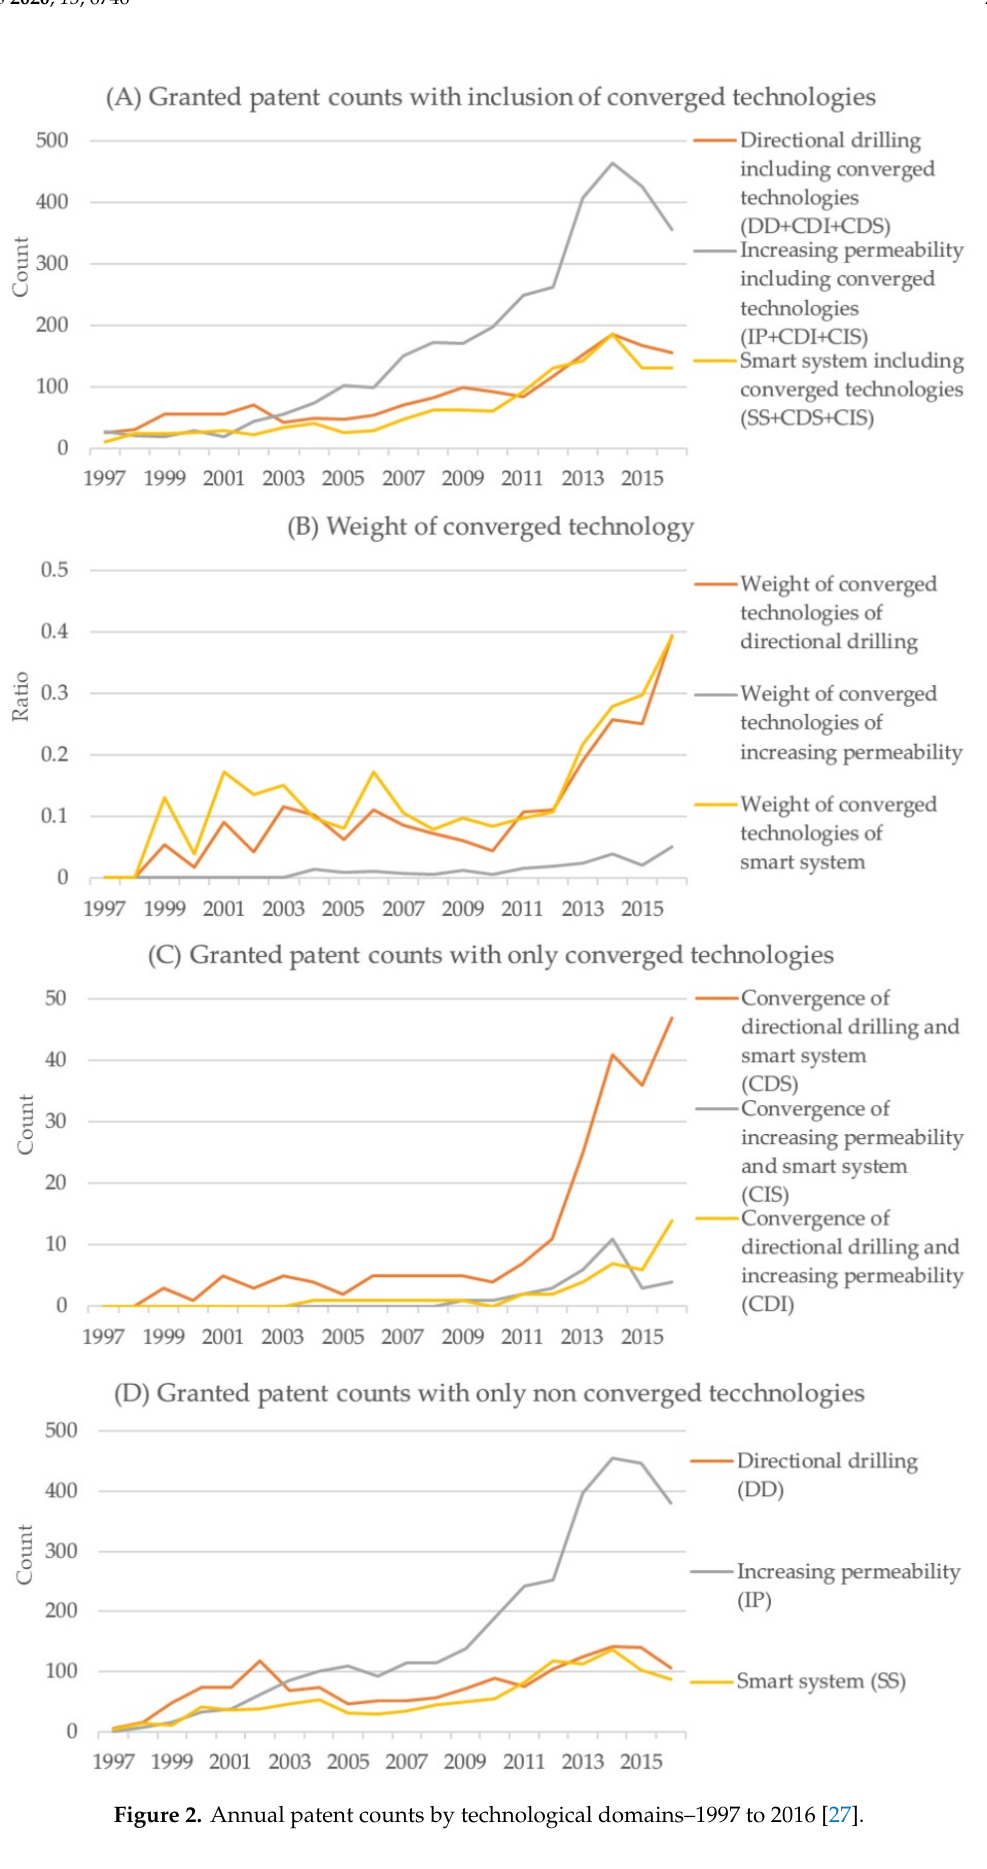
Figure 2. Annual patent counts by technological domains–1997 to 2016 [27].